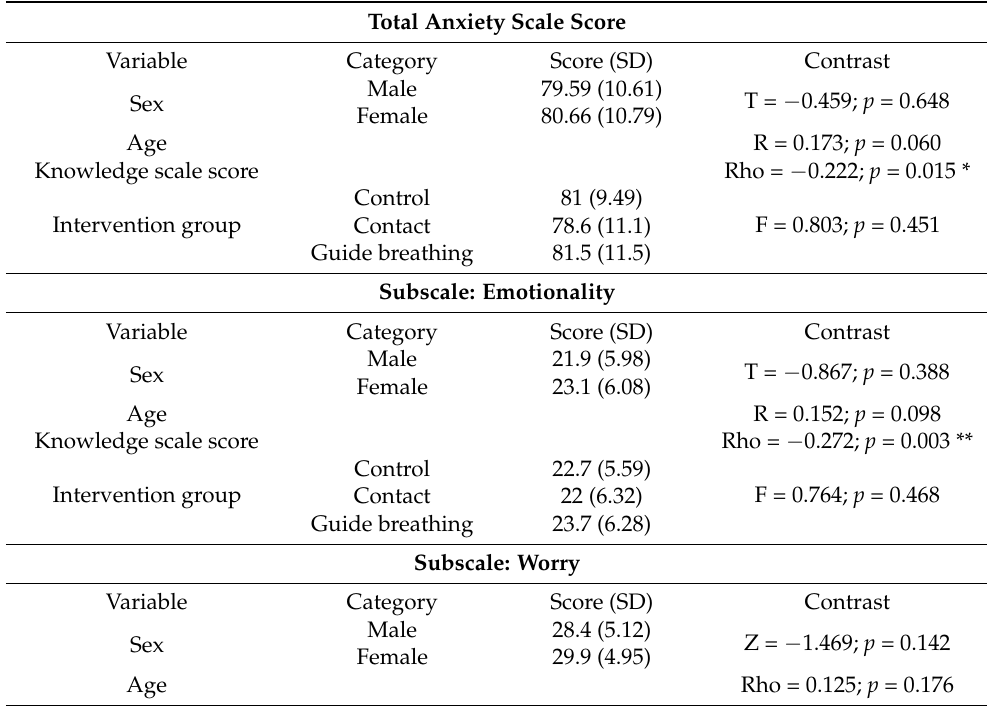
Table 2. Bivariate analysis of the anxiety